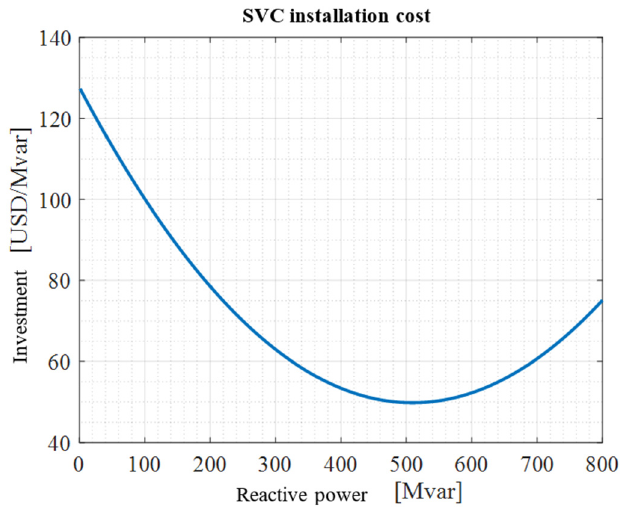
Figure 1. SVC cost function.